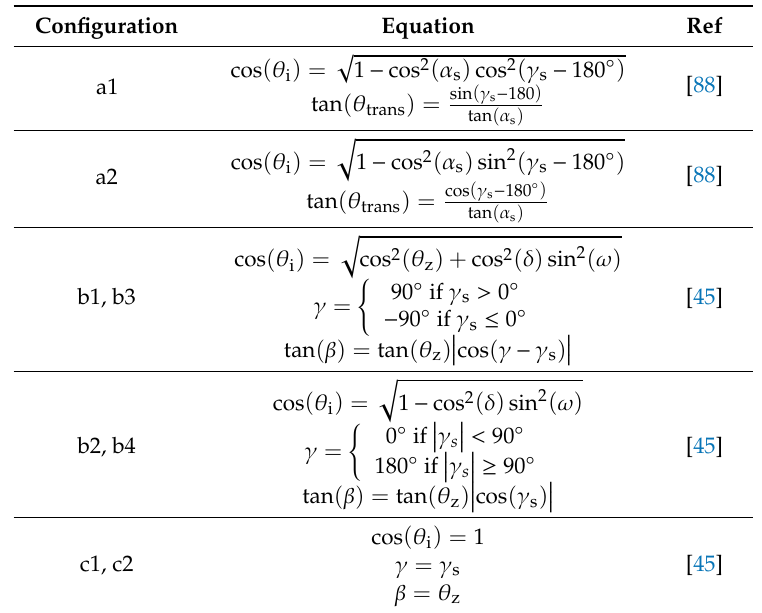
Table A1. Tracking